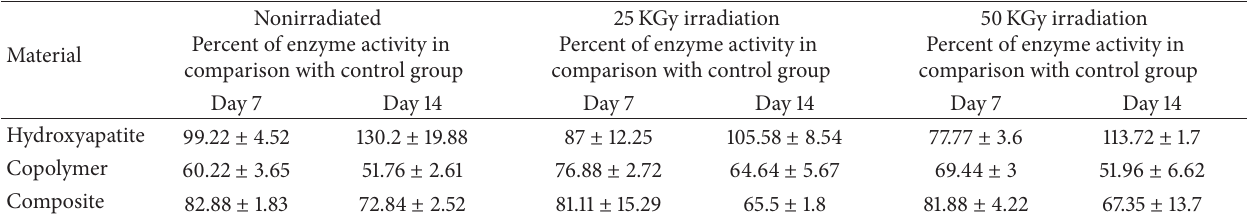
Table 6: Detailed results of alkaline phosphatase activity test (percent of enzyme activity in comparison with control group) for hydroxyapatite, copolymer, and composite under 0, 25, and 50 KGy doses of gamma irradiation in days 3, 7, and